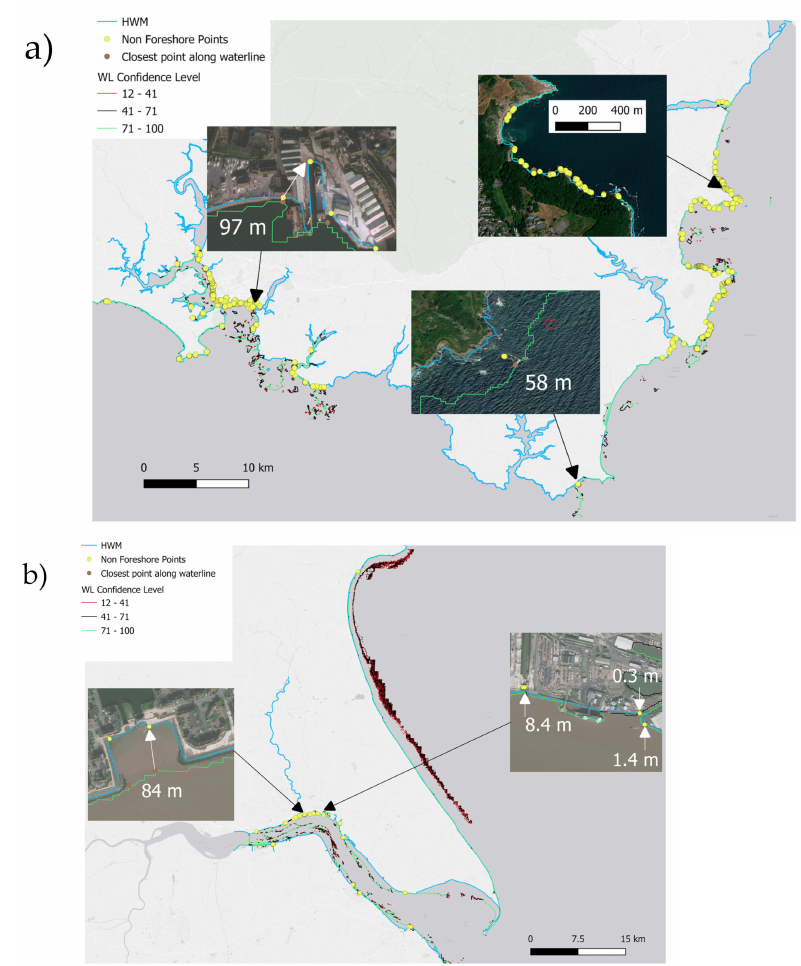
Figure 11. Results of the quantitative accuracy assessment; ( a ) at Site #3 for waterline extracted from sentinel-2 MSI taken 2 October 2019 at 11:21 UTC and ( b ) at Site #1 & #2 for waterline extracted from sentinel-2 MSI taken 25 June 2020 at 11:06 UTC. Yellow circles represent the non-foreshore points and brown circles the closest points along the waterline, represented as colored lines using the average of the two quality control scores. Distances between each point are indicated as text. Source of aerial imagery: Esri, Maxar, GeoEye, Earthstar Geographics, CNES/Airbus DS, USDA, USGS, AeroGRID, IGN, and the GIS User Community, v10.6. Source of Light Gray Canvas Base map: Esri, HERE, Garmin, © OpenStreetMap contributors, and the GIS user